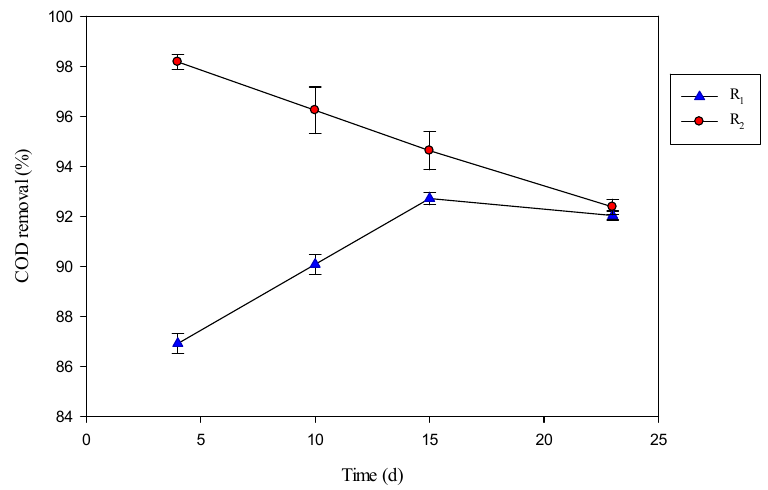
Fig. 2. Effect of Fe